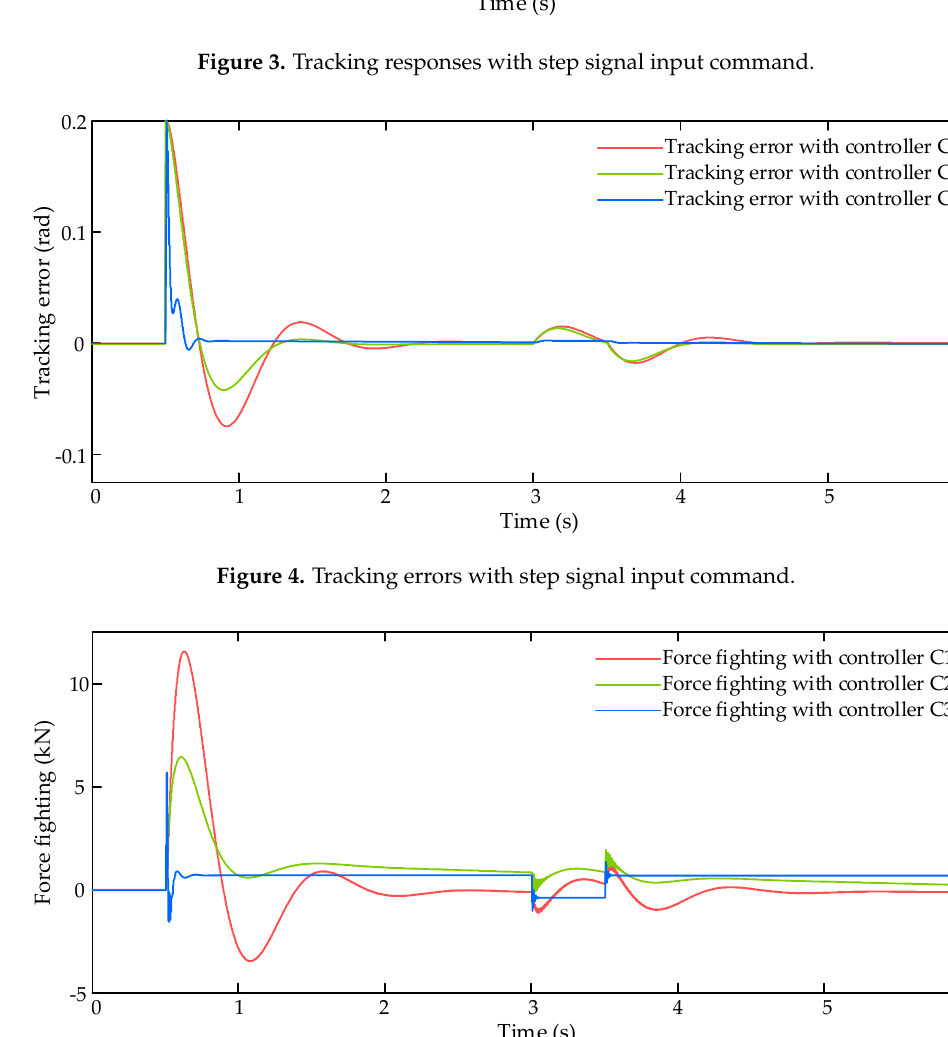
Tracking response with controller C3 Figure 6. Tracking responses with dynamic signal input command. Figure 6. Tracking responses with dynamic signal input command.